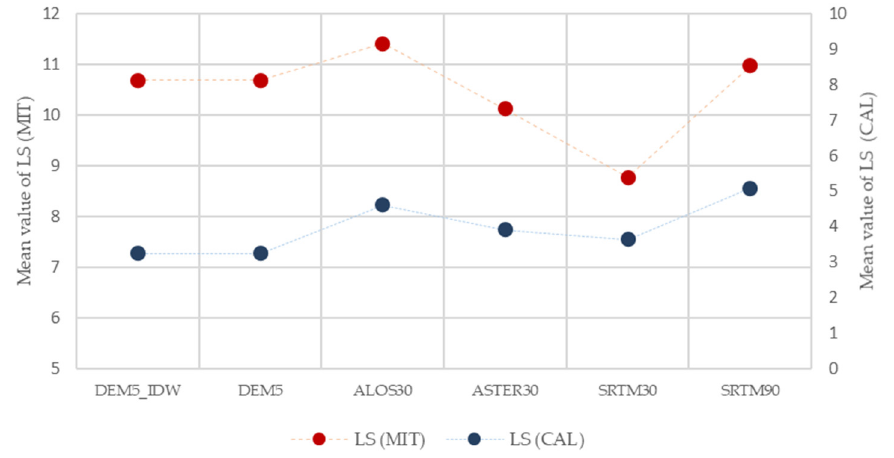
Figure 9. Mean LS values for each DEM using MIT and CAL